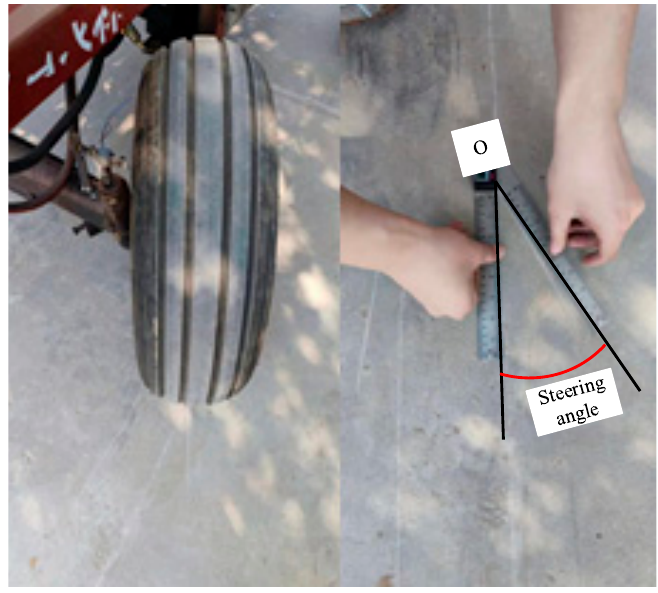
Figure 19. Steering angle test. Table 10. Maximum steering angle test results.